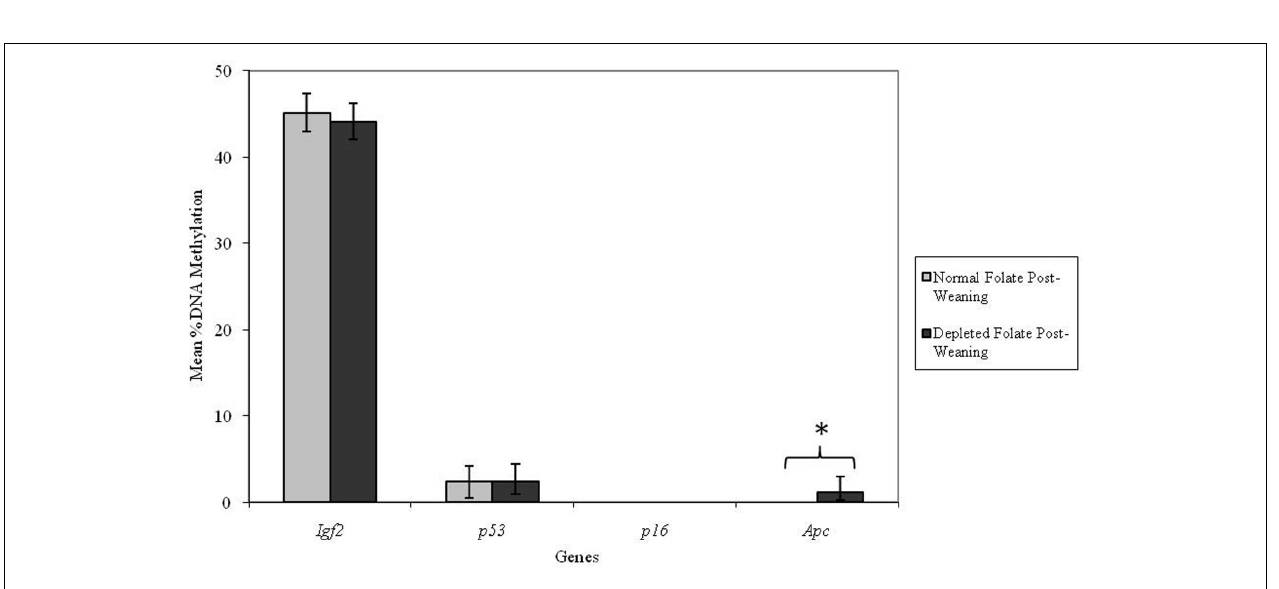
FIGURE 3 | Effect of depleted versus normal maternal dietary folate supply on gene-specific DNA methylation (%) in proximal SI of adult offspring (both Apc + /Min andWT mice combined; mean age 96days). Igf2 ,